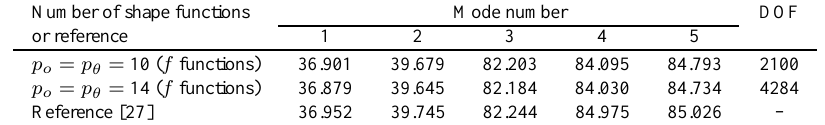
Table 3 First five frequencies (in Hz) of a CFCF cylindrical shell a = 0.25 m, b = 0.4 m, h = 0.001 m Number of number of shape Mode number DOF elements functions or